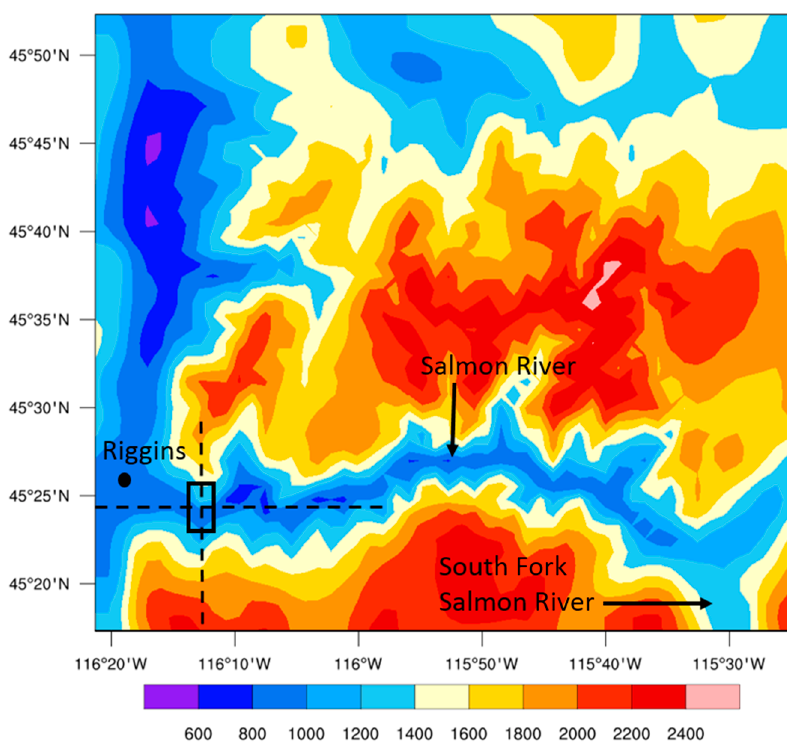
Figure 8. WRF 1.33 km domain with major geographical features and the study area labeled. Colors indicate terrain height in meters in the GMTED10 digital elevation model used for the simulations. The dashed black lines indicate transects along which vertical profiles are extracted for analysis.